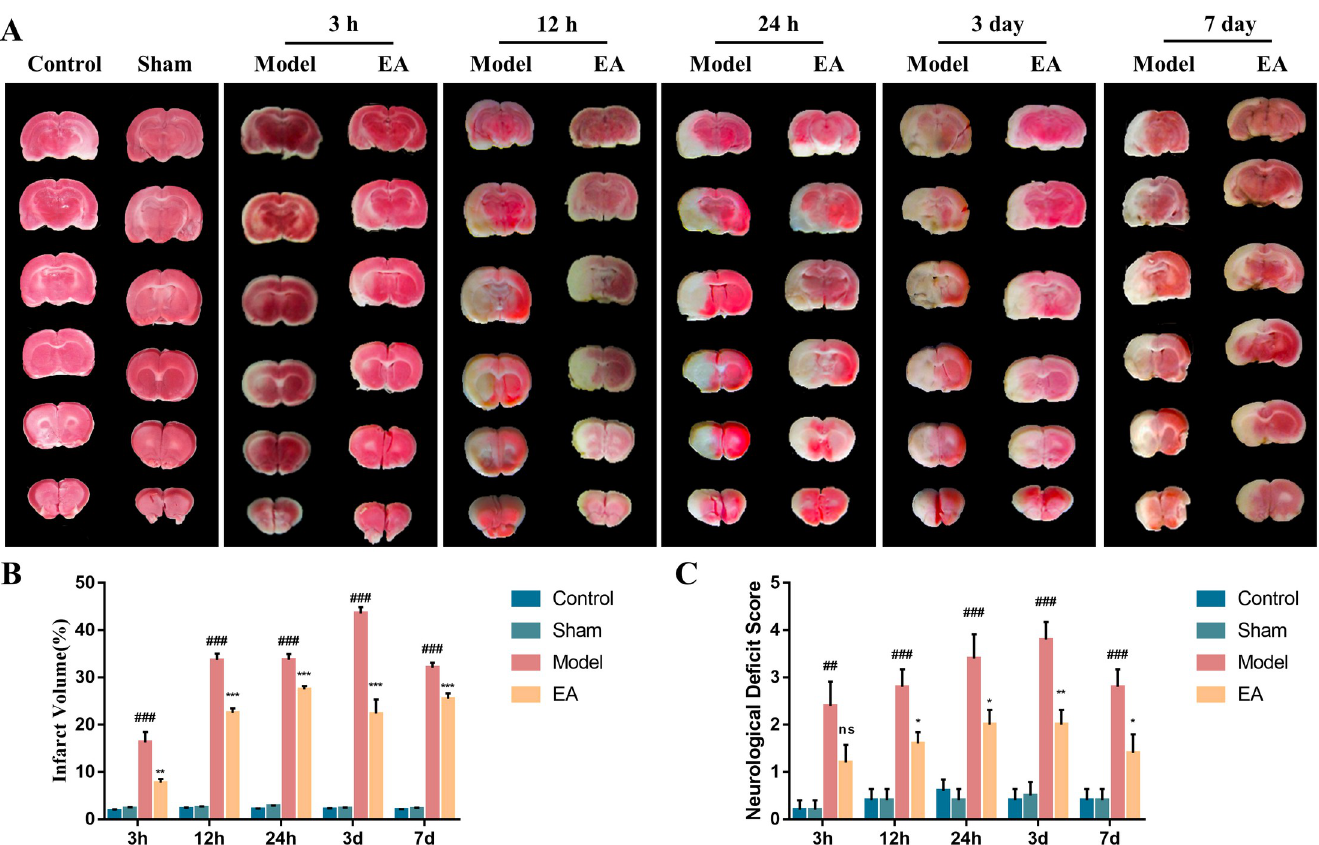
Fig 2. EA ameliorates infarct volume and neurological deficit score in CIRI rats. (A) Representative images of the TTC staining at different time points in the control, sham, model and EA groups. After TTC staining, red represented normal tissue, while white showed the infarcted area. (B) Quantification of infarct volume in each group (n = 5). (C) Quantification of neurological deficit score (n = 5). Data were expressed as mean ± SEM. ## P < 0.01, ### P < 0.001 vs. sham group; � P < 0.05, �� P < 0.01, ��� P < 0.001 vs. model